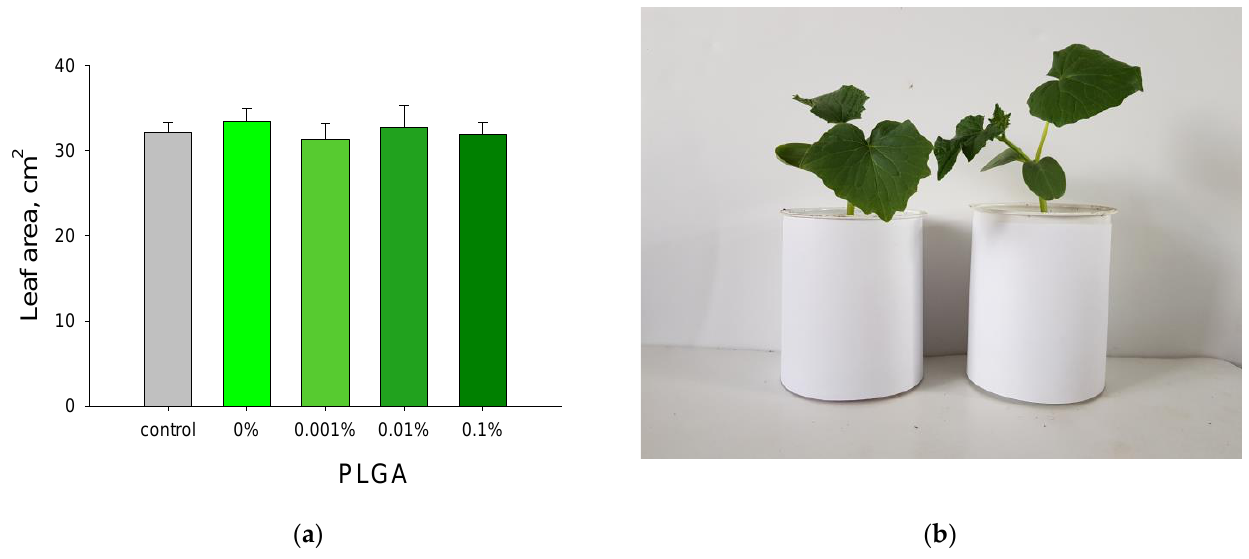
Figure 10. Influence of a nanocomposite based on PLGA and Al 2 O 3 NPs on the leaf size of plants: ( a ) Leaf size of Solanum lycopersicum . Data are presented as means and standard errors of the means; ( b ) Comparative photo of Cucumis sativus (plant in presence of nanocomposite is on the right).